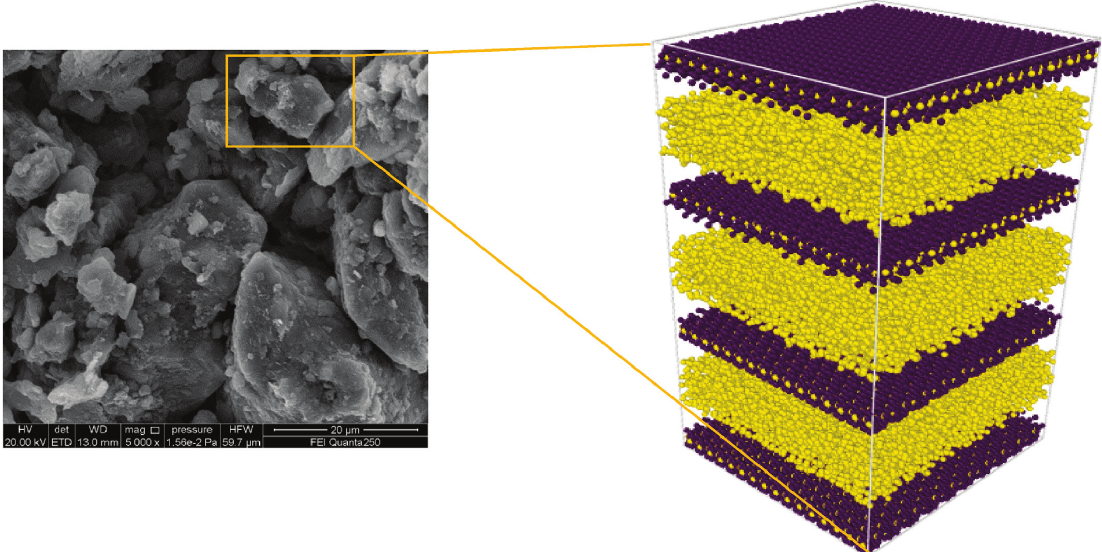
Figure 7: Initial model construction intention of soil